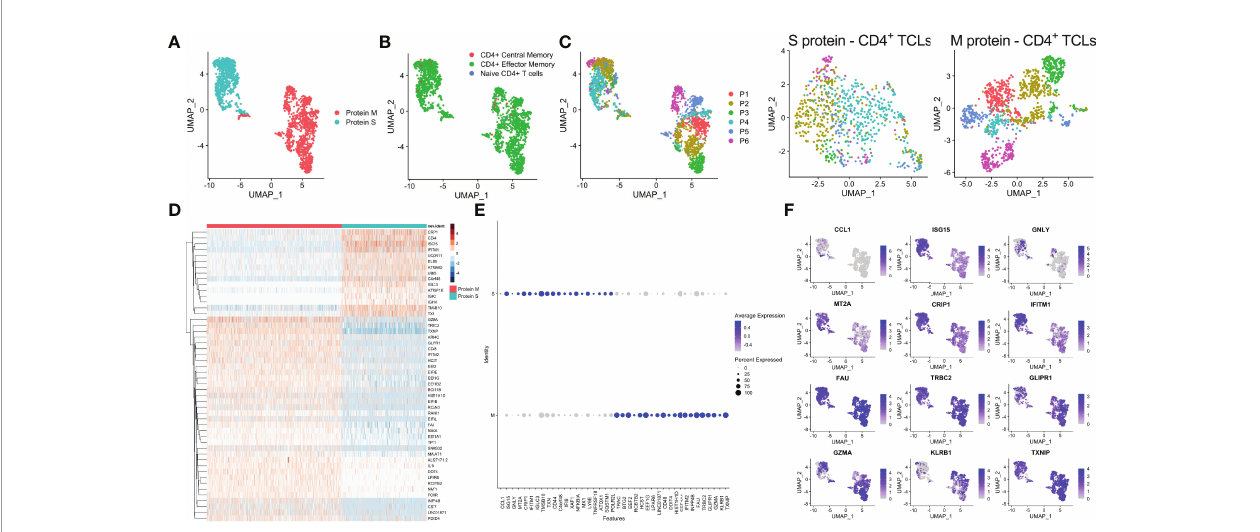
FIGURE 3 | Single-cell transcriptional pro fi ling of SARS-CoV-2 spike (S) and membrane (M) protein-speci fi c CD4 + T cell lines (A) . SingleR analysis utilizing Novershtern Hematopoietic database for cell identi fi cation (B) . Exome SNP data by Demuxlet algorithm was used to call cell genotypes in order to demultiplex the aggregate analysis of both S-reactive or M-reactive TCLs by patient-speci fi c manner (colored from P1-P6) is displayed by manifold approximation and projection (UMAP) (C) . (D) Heatmap showing expression of the most signi fi cantly 50 enriched transcripts in each cluster. Dot and feature graph highlighting the average expression and percent expression of selected marker transcripts in each cluster (E, F)